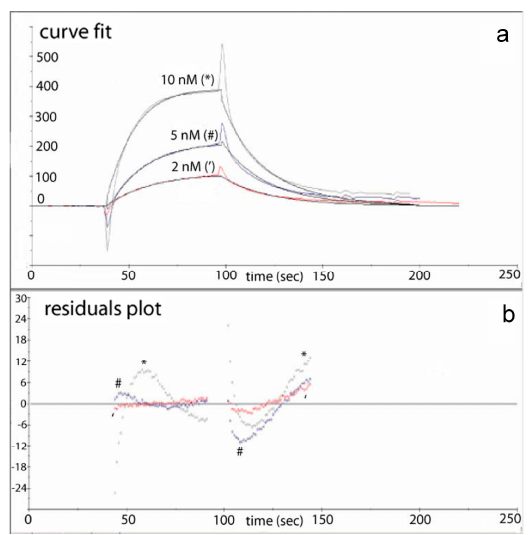
Figure 3. An example of fitting the SPR data with a 1:1 Langmuir binding model. ( a ) Curve fits for 2 nM, 5 nM and 10 nM DNA-PKcs samples; ( b ) Residual plots for the fitting curves shown in panel a. * = residuals plot for the 10 nM DNA-PKcs experiment, # = residuals plot for the 5 nM DNA-PKcs experiment, ‘ = residuals plot for the 2 nM DNA-PKcs experiment. Reproduced from [28].